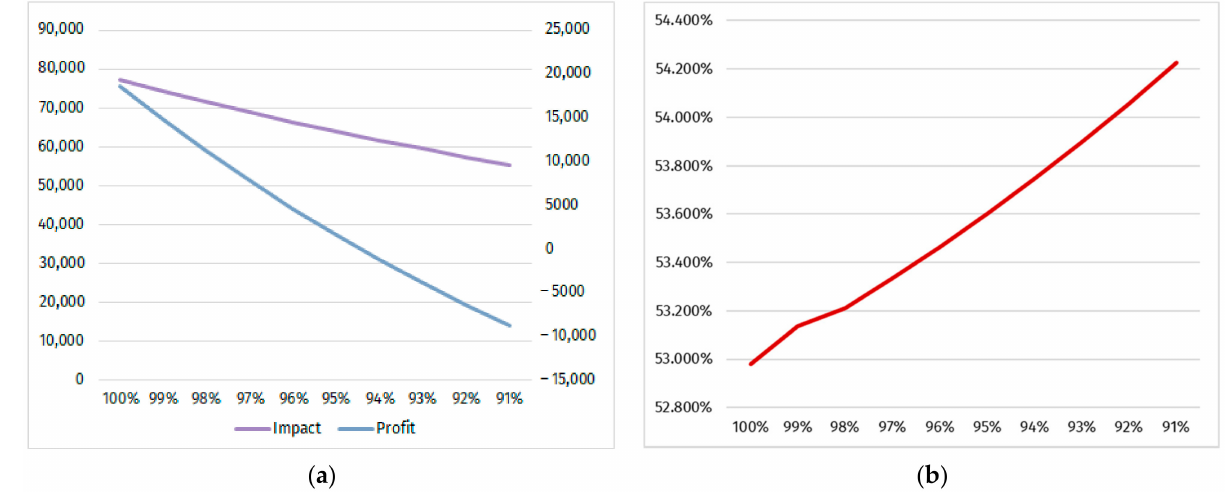
Figure 7. Results under varying process unit efficiencies: ( a ) Profit and environmental impact optimal values under varying process efficiencies; ( b ) objective function efficiency values under varying process efficiencies.